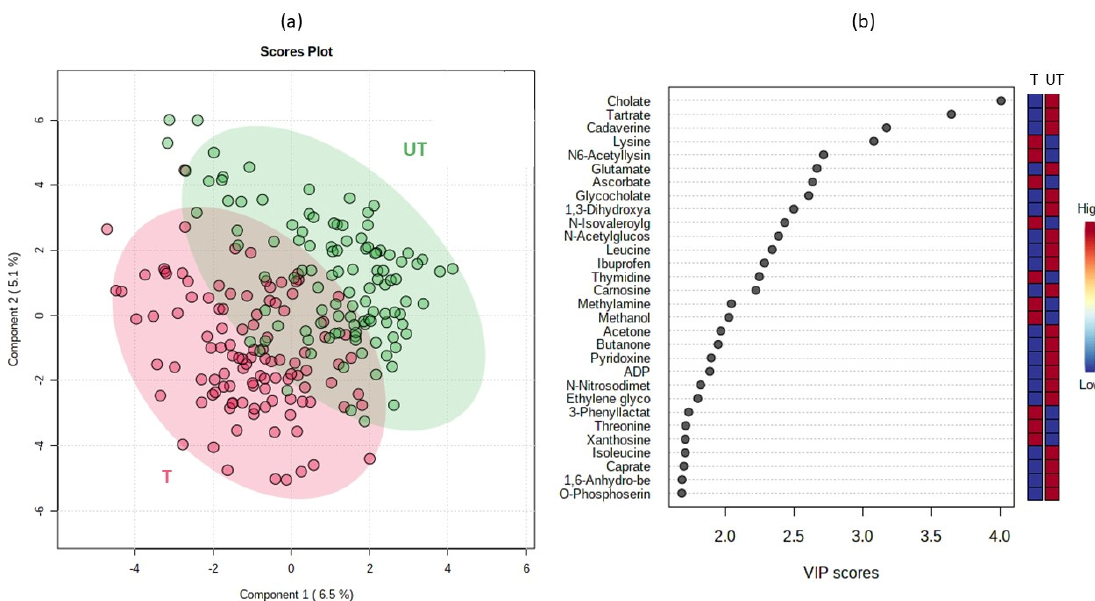
Figure 4. PLSDA ordination of metabolomics signatures present in the trained and untrained groups ( a , b ) VIP scores of the most important metabolites separating the two groups. The three-day series of urine samples of trained and untrained groups were analyzed with MetaboAnalyst. Prior to the PLSDA analysis, concentrations were transformed with Log10 normalization and scaled with Mean Centering approach. Each dot represents one sample of participant per